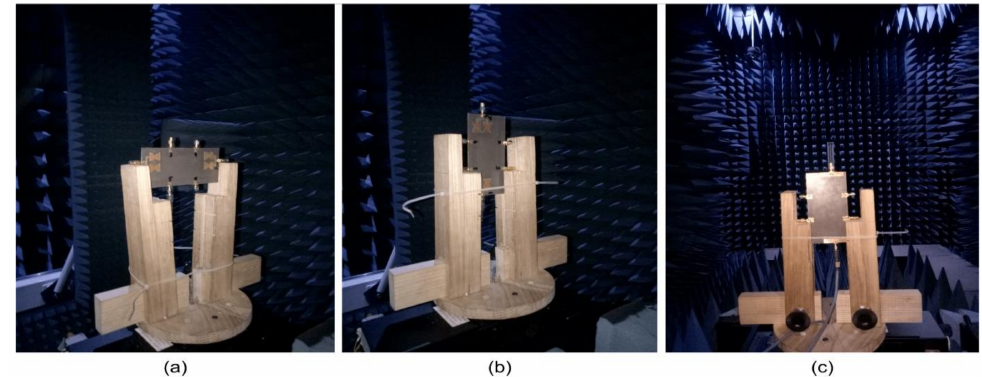
Figure 13. Antenna far field-testing setup: ( a ) mounted high-band (5G mmWave) antenna; ( b ) mounted mid-band MIMO, front; ( c ) mounted mid-band MIMO, back. Table 2. Simulated and measured gains for the mid- and high-band MIMO antennas. Sr.